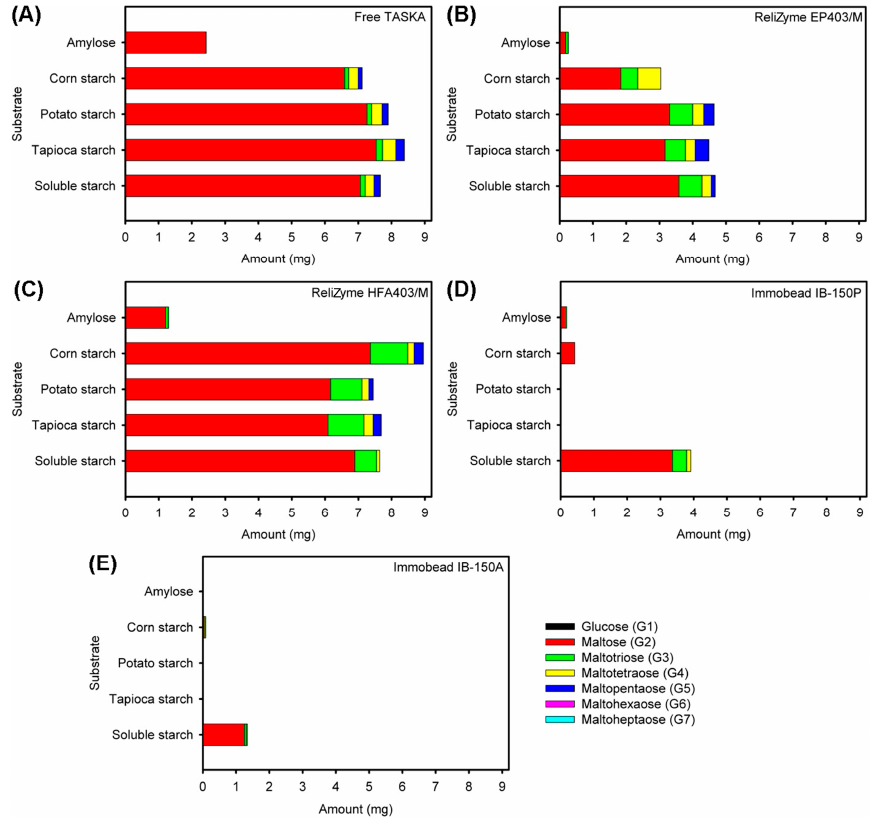
Figure 5. Analysis of reaction products on different substrates by HPLC-ELSD using ( A ) free TASKA and immobilized TASKA on ( B ) ReliZyme EP403/M; ( C ) ReliZyme HFA403/M; ( D ) Immobead IB-150P; and ( E ) Immobead IB-150A.